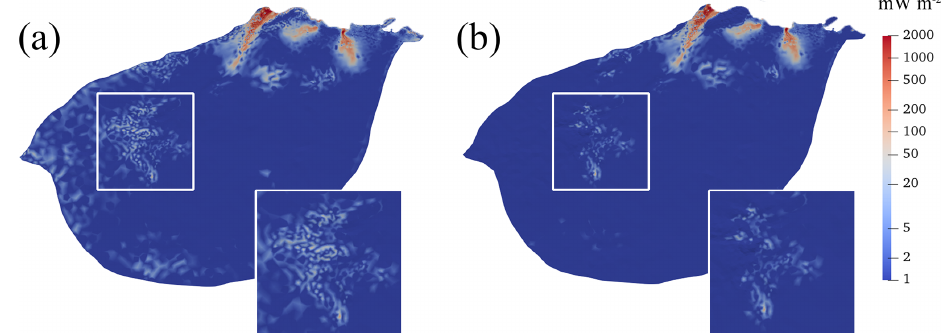
Figure 5. Comparison of modelled basal friction heat with basal friction coefficient β old (a) and β new with α = 1 (b) , as driven by Martos et al. (2017) GHF. The white square is enlarged.